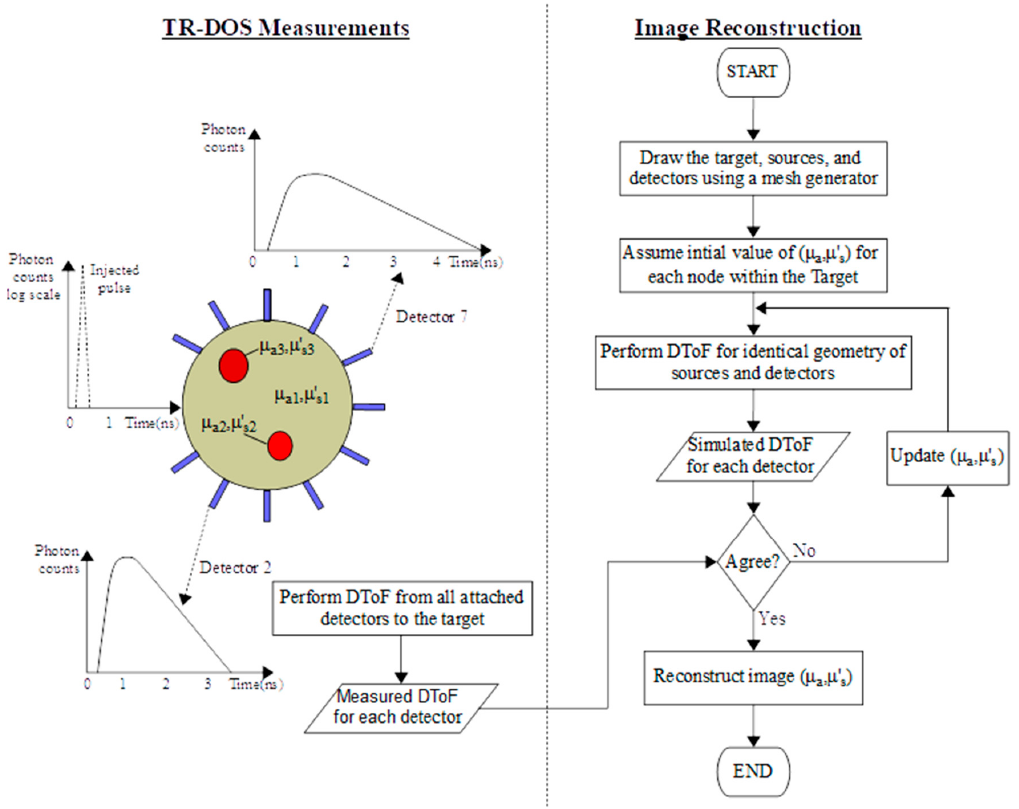
Figure 5. Flow diagram of a TR-DOT prototype, the left and right side represent the measurement setup (DOS) and the flowchart of the inverse modelling respectively.